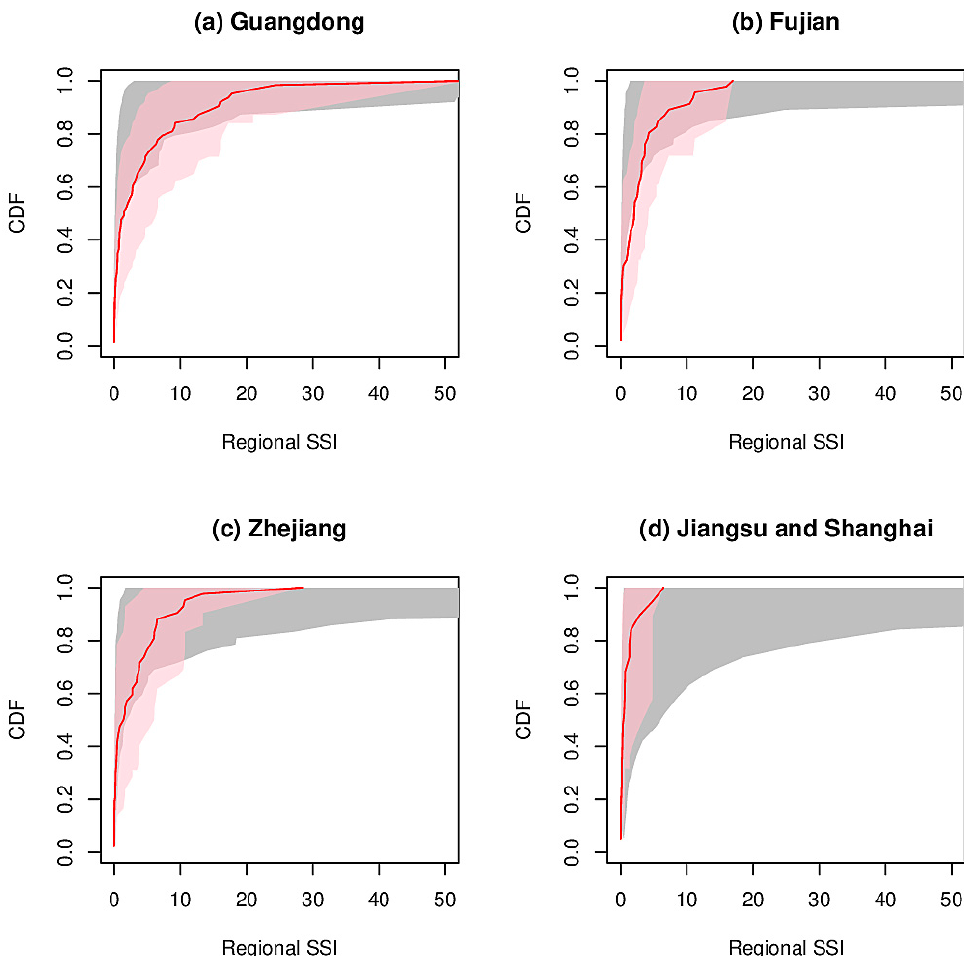
Figure A2. The cumulative distribution function (CDF) of the regional SSI in historical observations (red lines) for ( a ) Guangdong, ( b ) Fujian, ( c ) Zhejiang, and ( d ) Jiangsu and Shanghai. The grey areas indicate the range of CDF of the regional SSI in the 100,000 subsets of the TOT event set. The pink areas indicate the internal variability of the CDF of historical observations which are derived by bootstrap resampling with replacement.